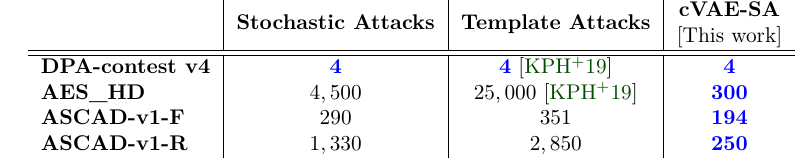
Table 3: Comparison of ¯ Nt rank value depending on datasets. The best performance for each dataset is denoted in